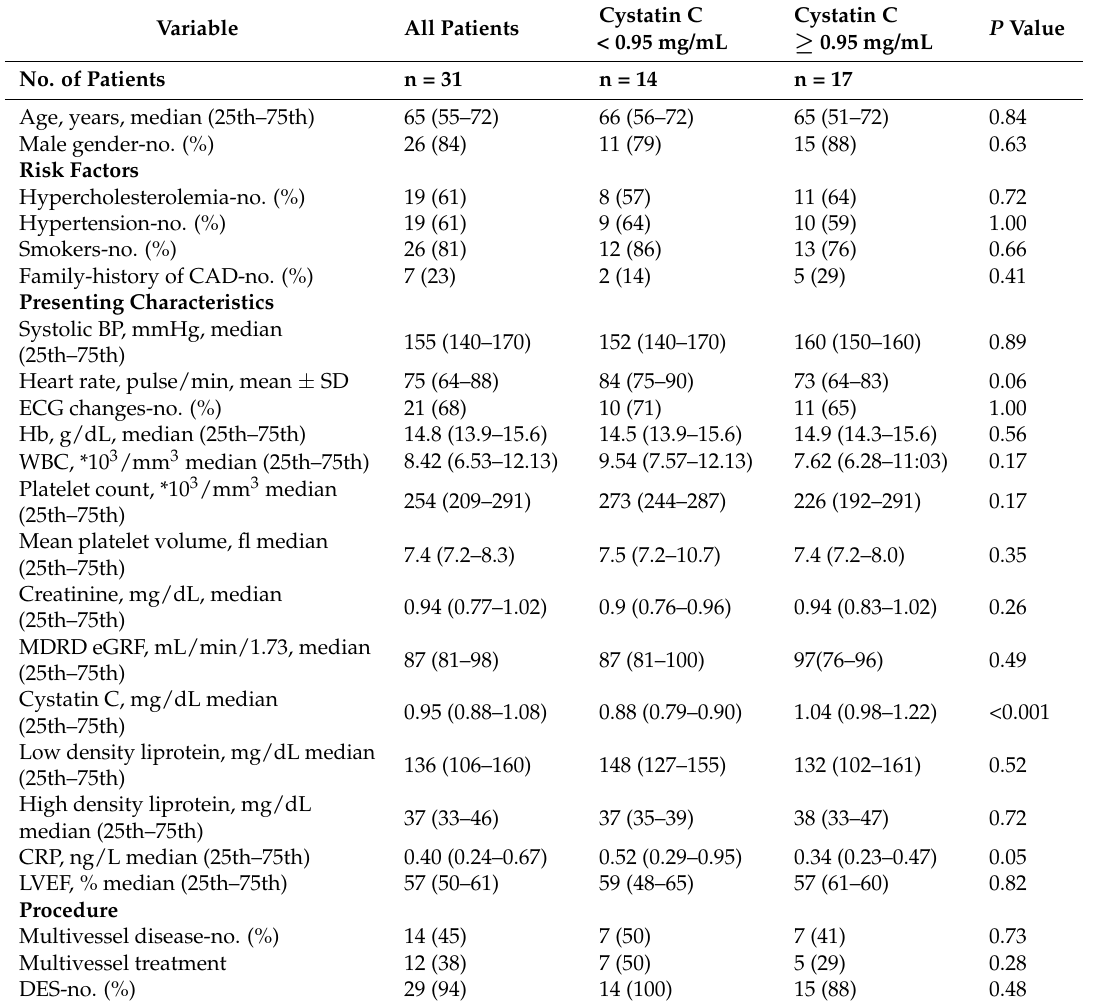
Table 1. Baseline